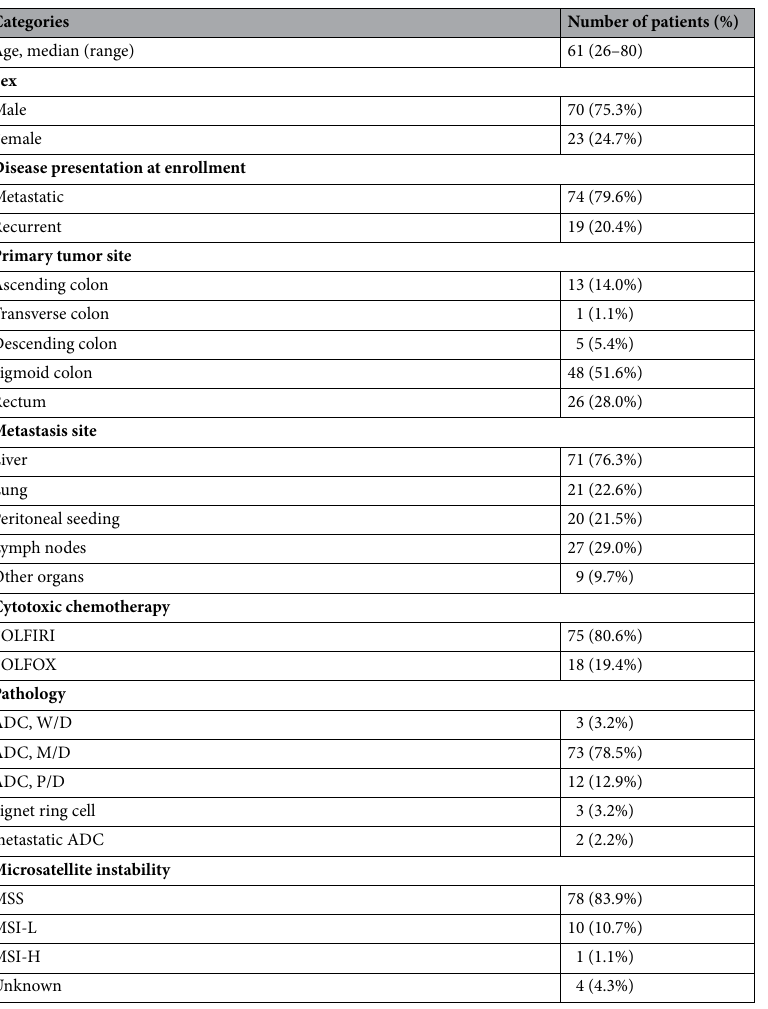
Table 1. Baseline characteristics (n = 93). FOLFIRI 5-Fluorouracil + Leucovorin + Irinotecan, FOLFOX 5-Fluorouracil + Leucovorin + Oxaliplatin, ADC adenocarcinoma, W/D well differentiated, M/D